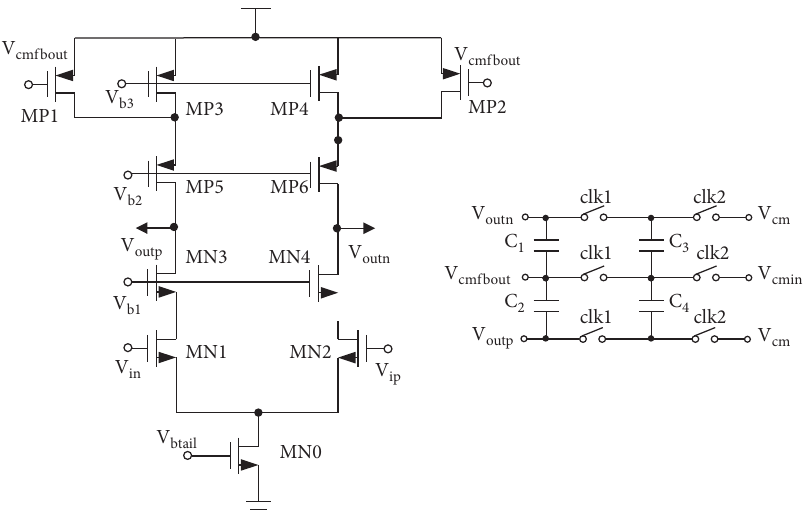
Figure 7: Fully differential single-stage telescope OTA.